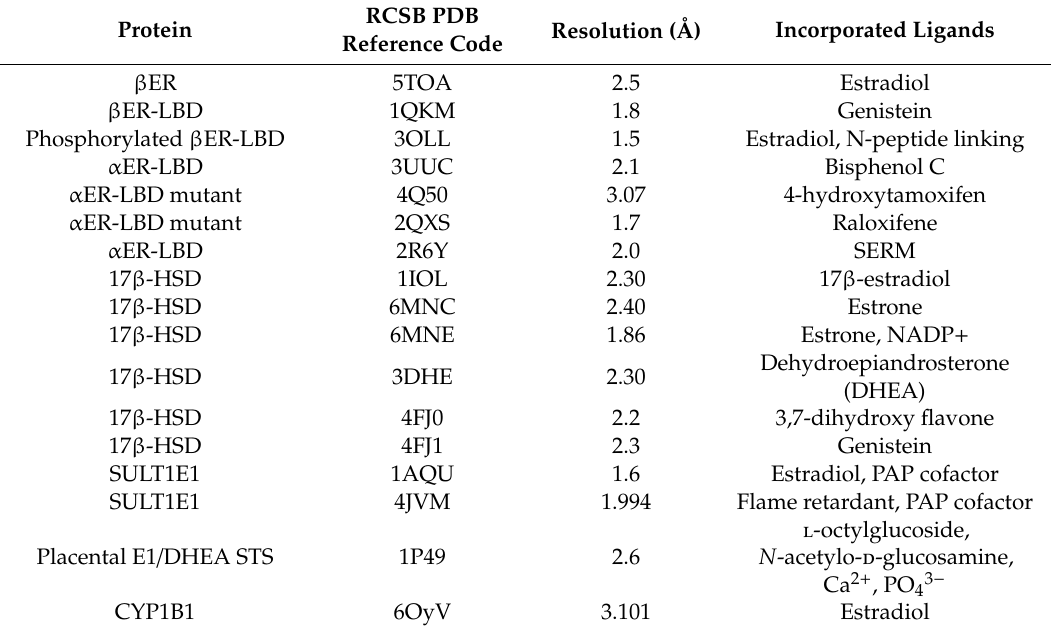
Table 2. Selected proteins involved in the metabolism of estrogens present in the RCSB PDB (Protein Data Bank) [48]. All structures were obtained using X-ray di ff